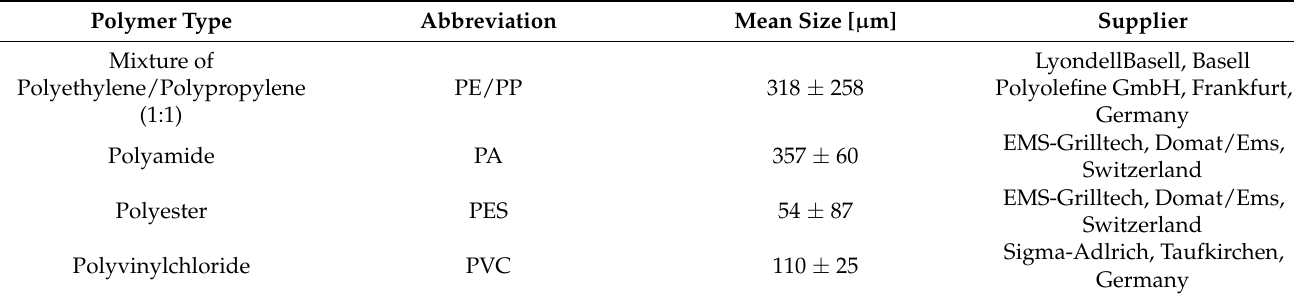
Table 1. Overview of microplastics used in the